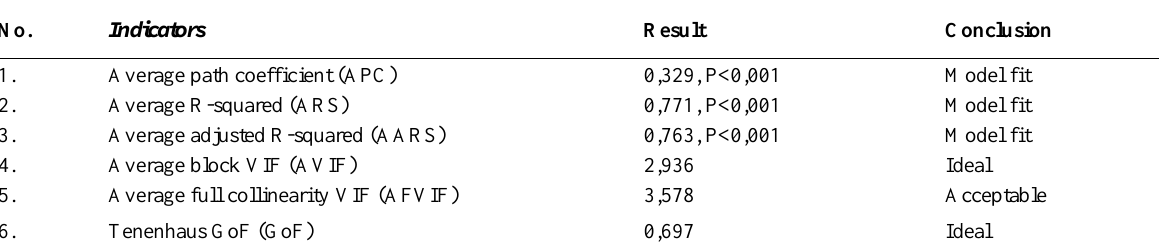
Table 5: The goodness of fit test